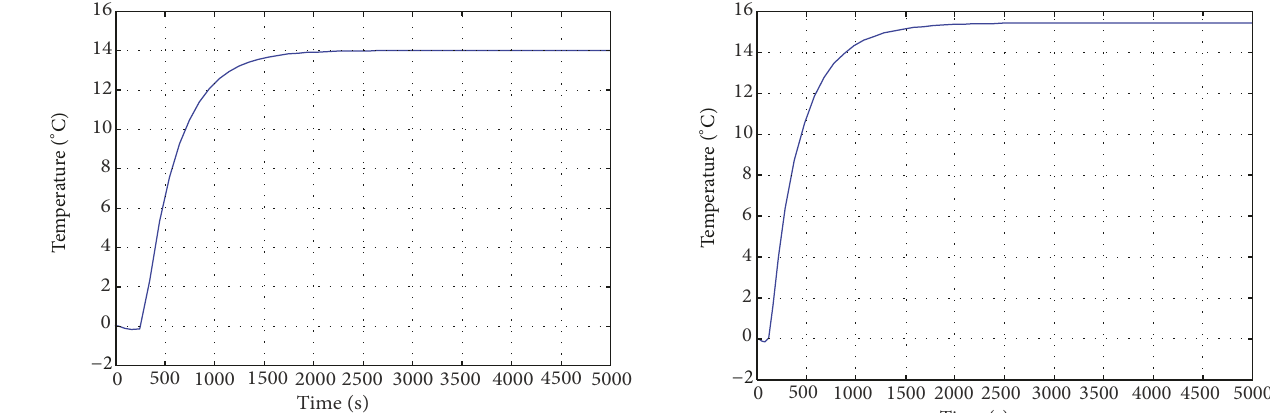
Figure 6: The variation curve of 𝑦 1 when the load of generator unit is 600MW, 𝑢 𝑗 ∈ [0,12] , and the increment of 𝑢 2 is 4.